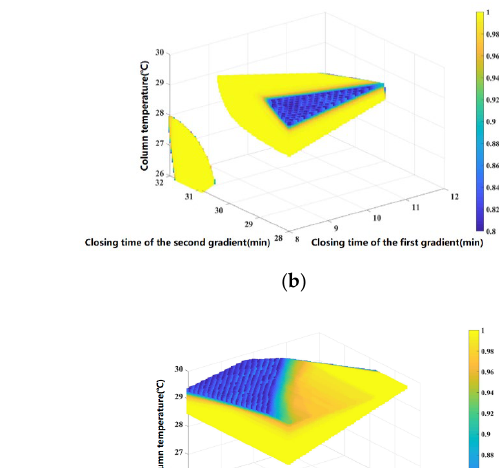
Table 6. Validation of experimental conditions and results. Meth- ods